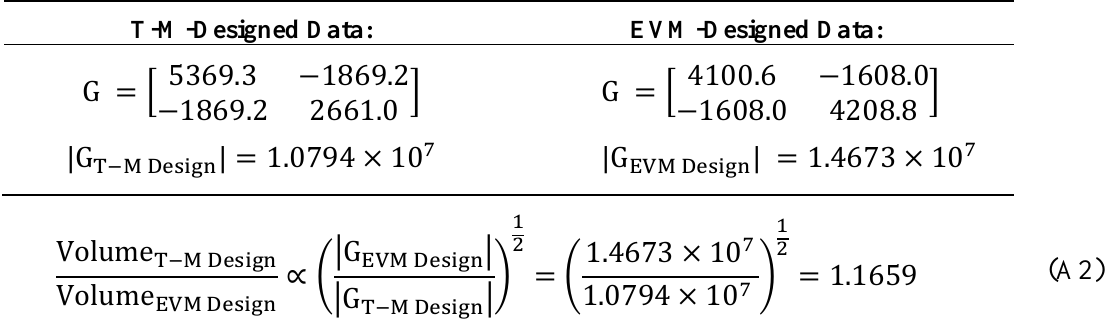
Table A5. Comparison of design criteria for AMPS/AAc